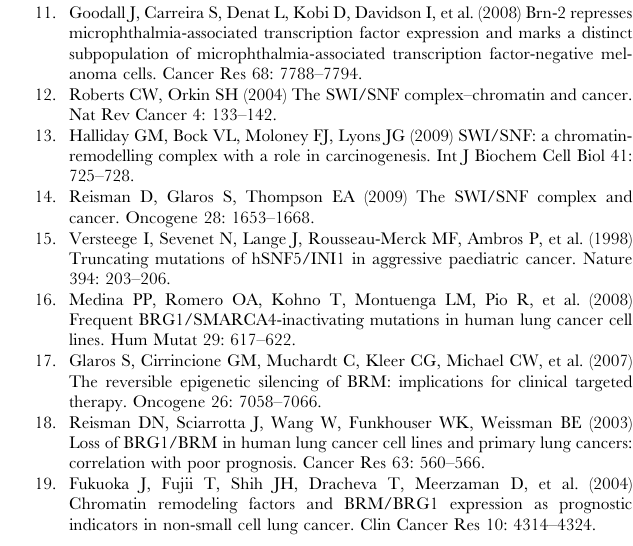
Table S2 Known MITF target genes downregulated more than 2-fold by BRG1 knockdown in 501mel cells